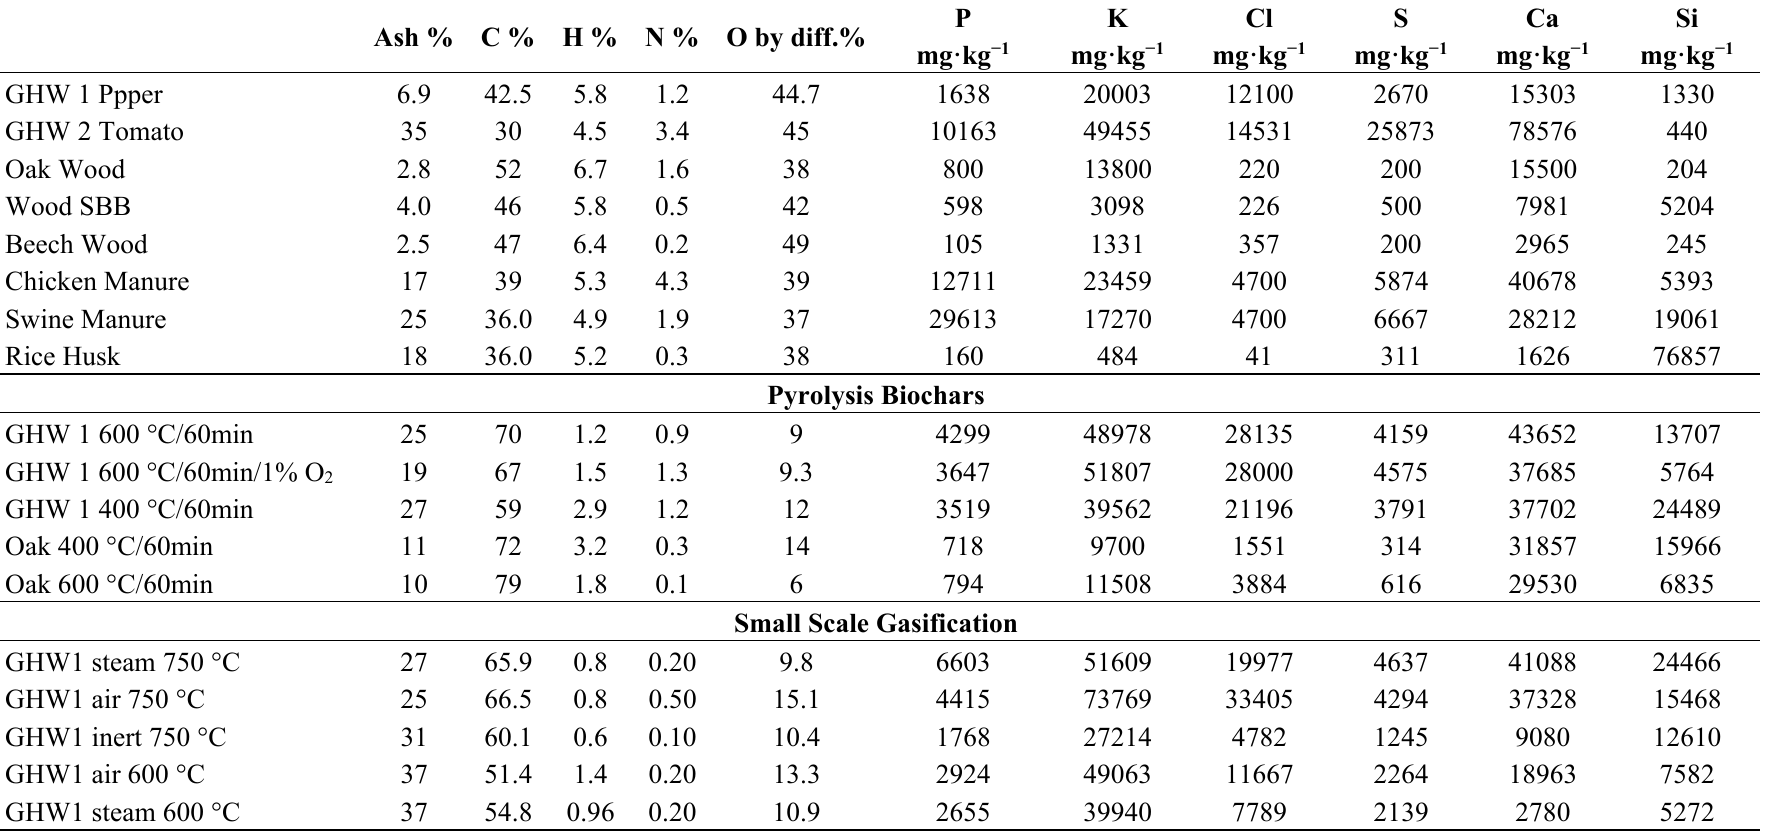
Table 4. Ultimate, proximate and main inorganic elements of the feedstock and produced